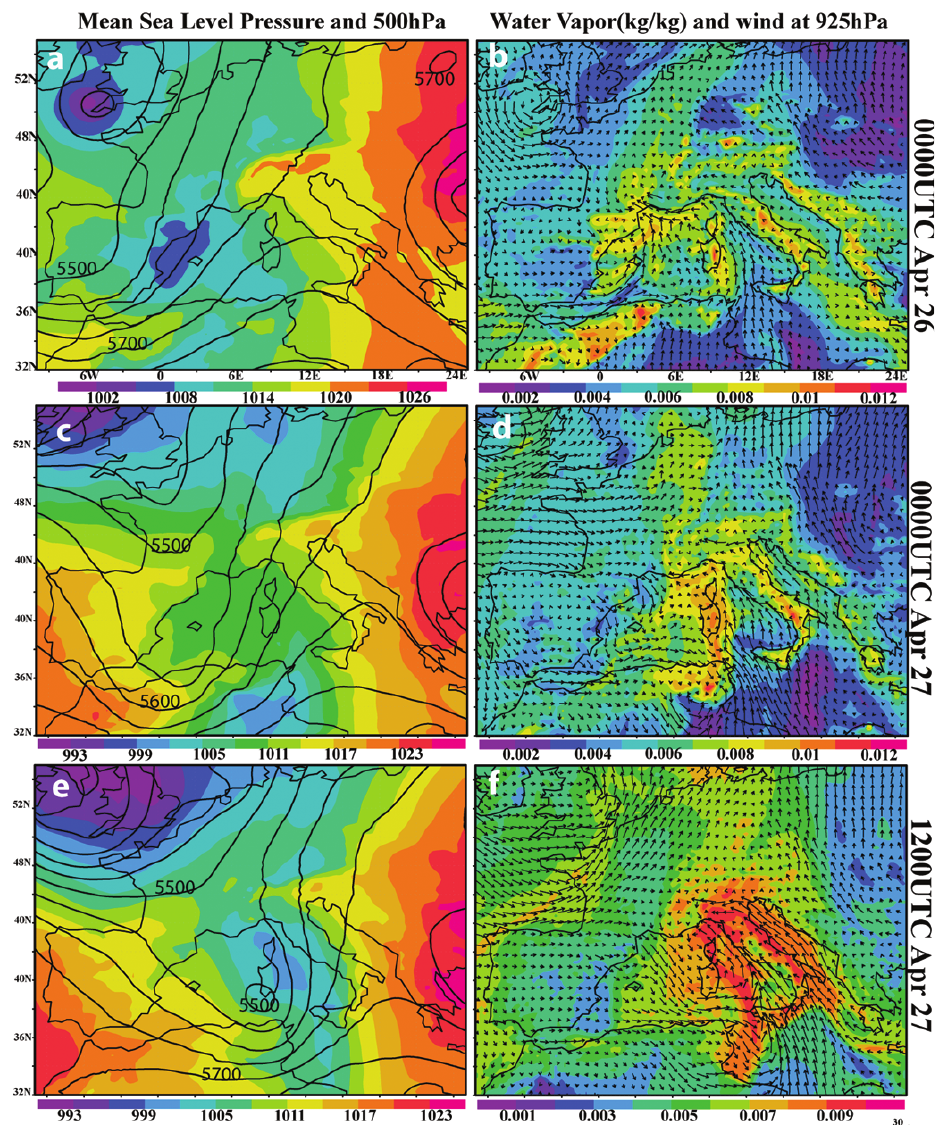
Fig. 1. ECMWF analyses mean sea level pressure (shaded) and 500hPa geopotential height (contour interval = 50gpm) on the left side; 925hPa water vapour mixing ratio (kgkg − 1 ) and wind on the right side. For 26 April 2009 at 00:00UTC on the top panel, 27 April 2009 at 00:00UTC on the middle panel, 27 April 2009 at 12:00UTC in the bottom